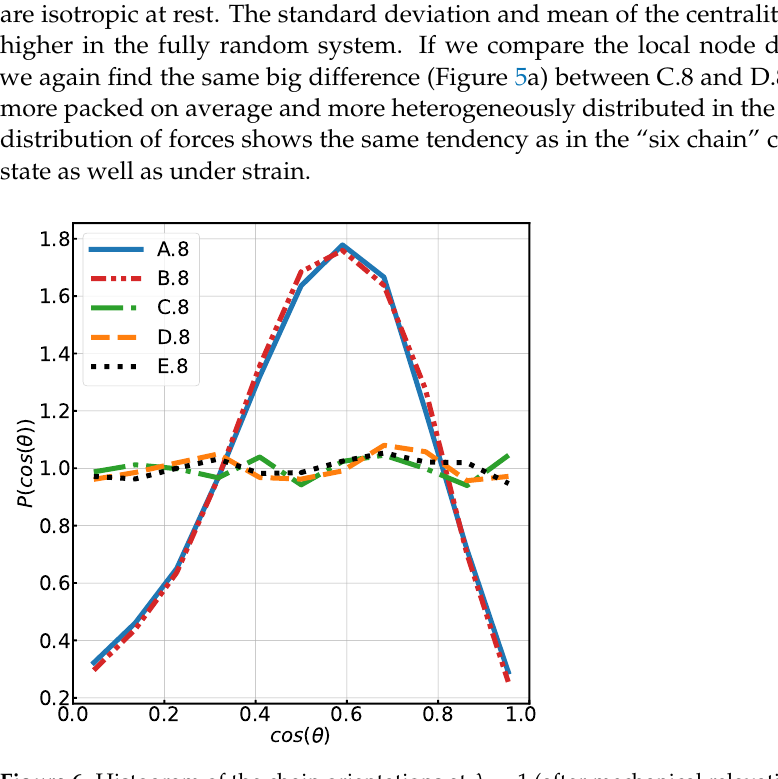
Figure 6. Histogram of the chain orientations at λ = 1 (after mechanical relaxation) for systems with a mean node connectivity equal to 8. θ is the tilt angle of the chains with respect to stretch axis. For the systems C.8 to E.8, the orientation of chain orientation is isotropic. The corresponding figure for connectivity 6 is shown in the